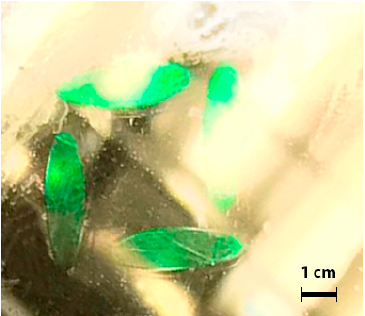
Figure 7. Photography of four holographic reflection gratings daylight illuminated. 373